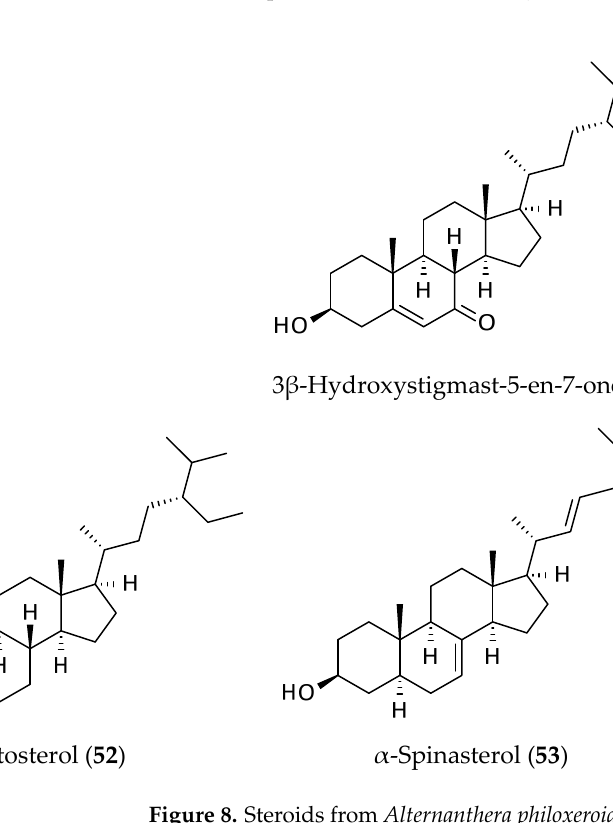
Figure 7. Saponins from Alternanthera philoxeroides .